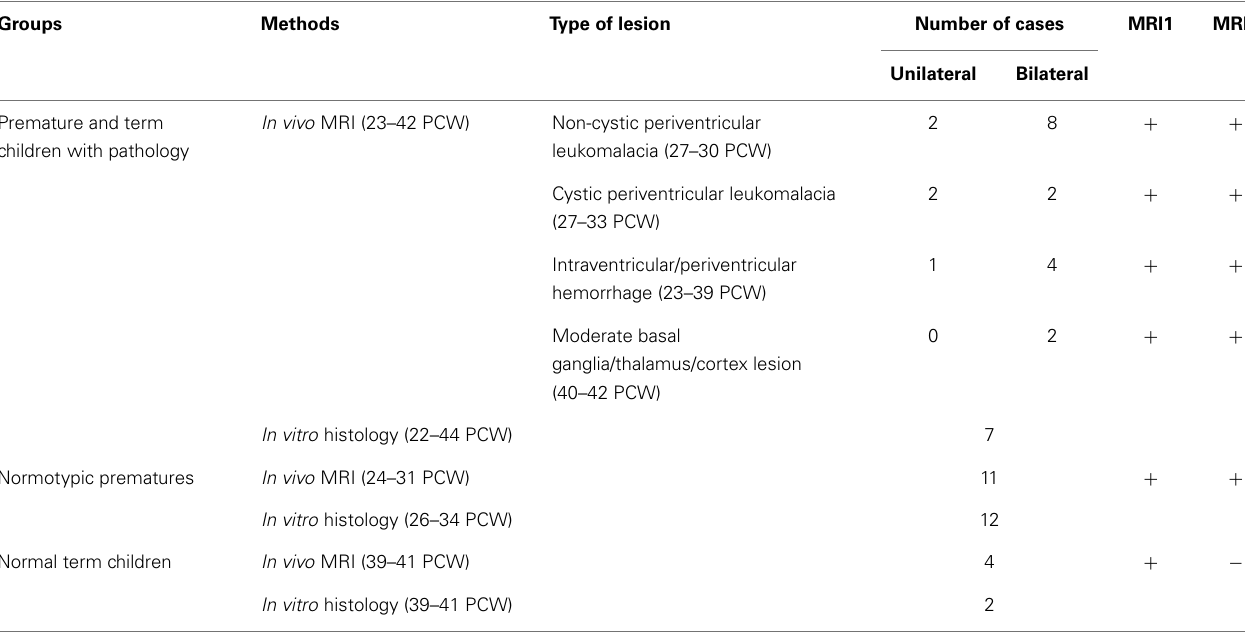
Table 1 | Groups of children included in histological ( in vitro ) and MRI ( in vivo ) study with classification of lesion on MRI according to SCPE grading system